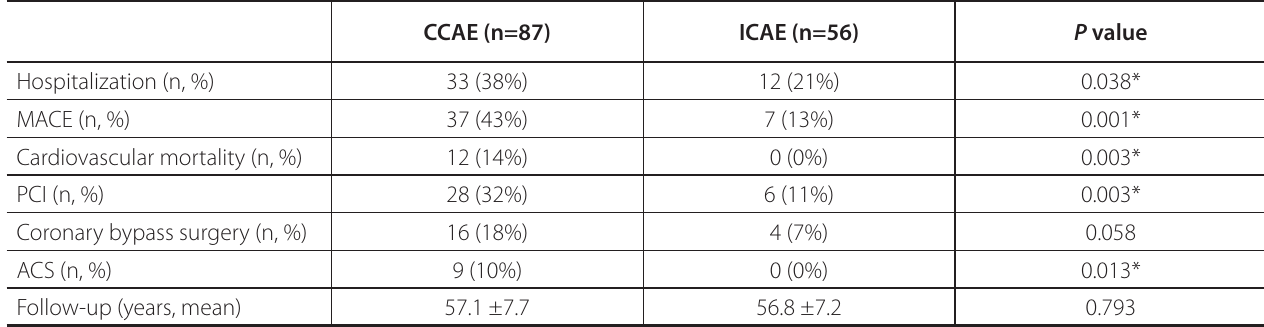
Table 3 . Follow-up data of the